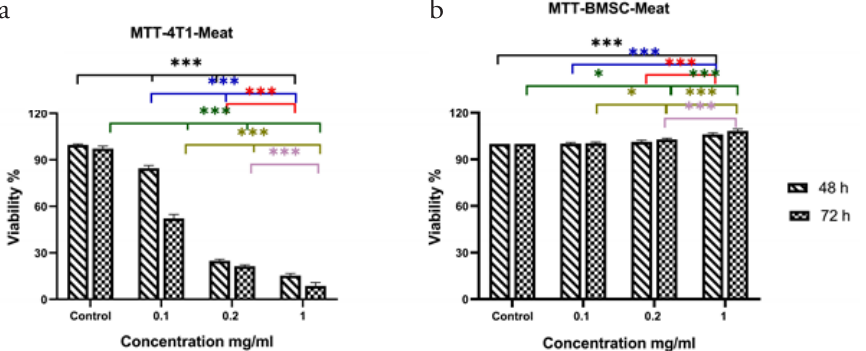
Figure 5. 4T1 Cells (a) and BMSCs (b) Viability (%) in Different Concentration of Crab Meat Extract by MTT Assay Cell viability in the 4T1 cancer cell line was decreased in a dose- and time-dependent manner. In the BMSCs, cell growth was increased in a dose- and time-dependent manner. There is significant difference between the groups ( P ≤ 0.001***, P ≤ 0.01*). The data is shown as mean ± SD.